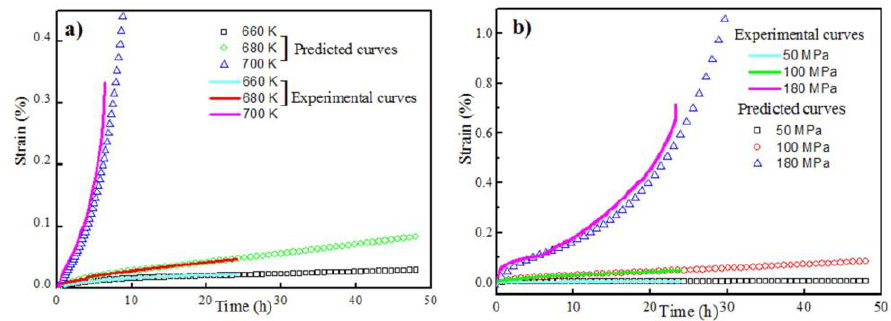
Figure 6. Comparisons between the experimental curves and predicted curves: ( a ) 100 MPa for different temperatures and ( b ) 680 K for different applied stresses.